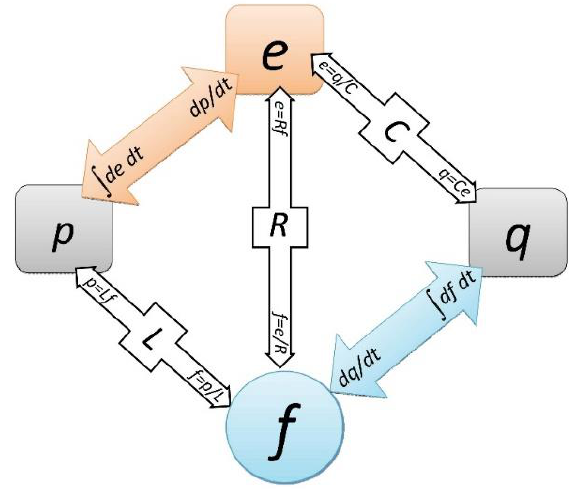
Figure 1. Generalized system properties: e —generalized effort, f —generalized flow, q —generalized accumulation, p —generalized momentum.